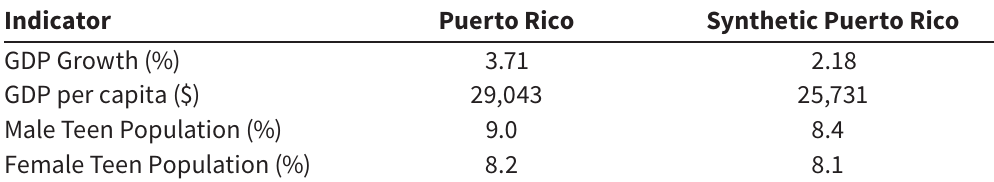
Indicators in Puerto Rico vs. Synthetic Puerto Rico Indicator Puerto Rico